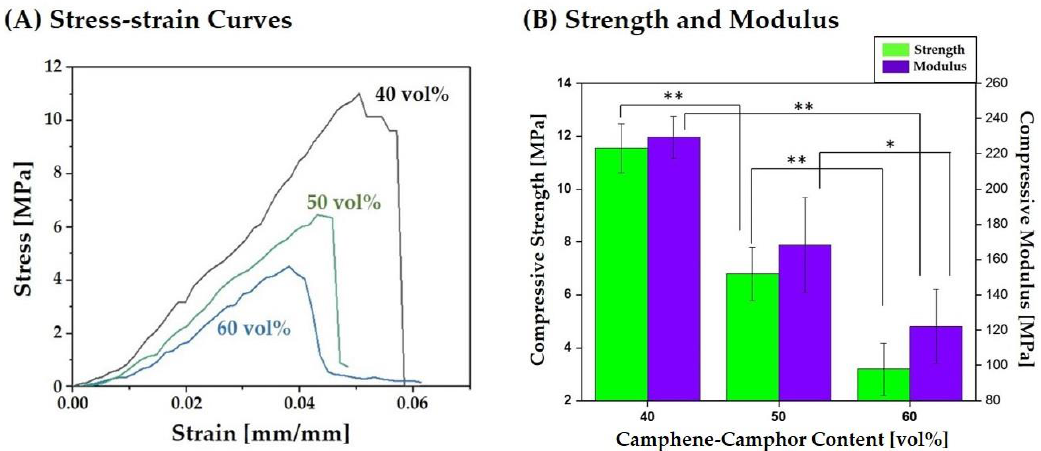
Figure 8. ( A ) Representative stress versus strain responses of the hierarchically porous CaP sca ff olds manufactured using a range of camphene-camphor amounts (40 vol %, 50 vol %, and 60 vol %). ( B ) Compressive strengths and modulus as a function of the camphene-camphor amount. Five samples were tested for each condition (* p < 0.05 and ** p < 0.01).